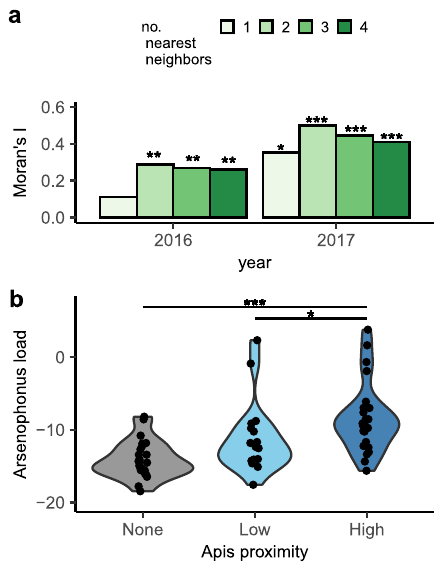
Figure 5. Spatial patterns in colony-level Arsenophonus sp. load. (a) Arsenophonus sp. loads are positively spatially autocorrelated, indicated by significantly positive Moran’s I tests for a variety of definitions of neighbors (k = 1–4 nearest neighbors). (b) Colony-level Arsenophonus sp. load is predicted by the proximity to feral honeybee hives in 2016. All “None” colonies were at the KK site, while “Low” and “High” honeybee colonies were at the HP site. Honeybee hives were not searched for in 2017. Violin plots produced in ggplot2. For map of Arsenophonus sp. load and honeybee hives, see Supplementary Figure S5. * indicates p < 0.05, ** indicates p < 0.01; *** indicates p < 0.001.